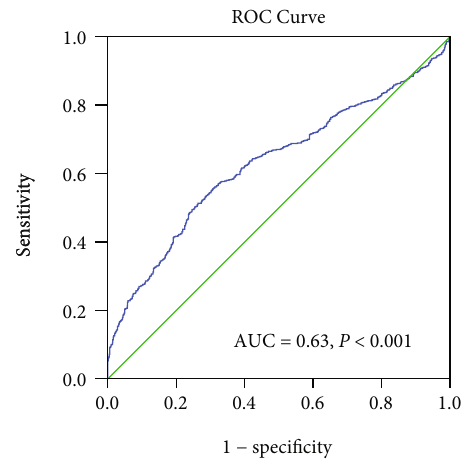
Figure 2: Receiver operating characteristic (ROC) curves of NLR to predict the presence of neonatal sepsis.